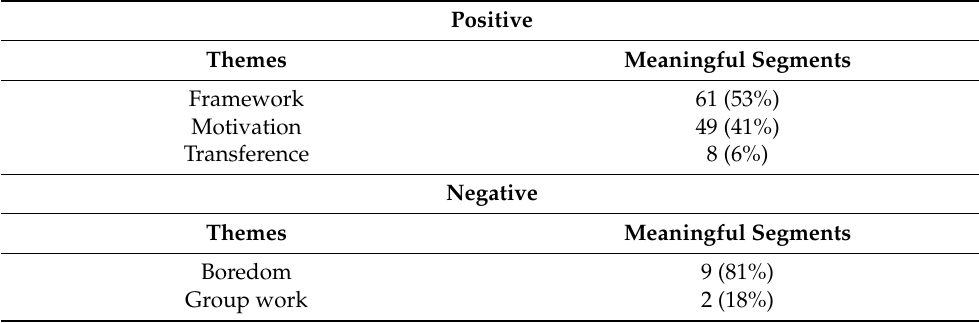
Table 2. Themes and meaningful segments from